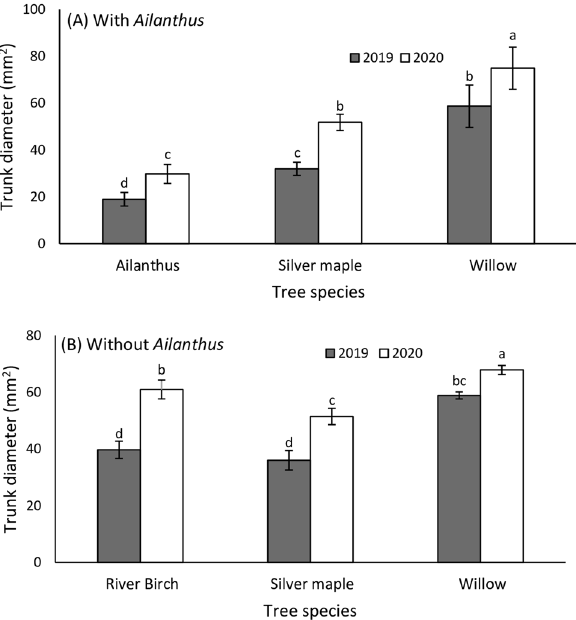
Figure 1. Mean (± SE) trunk diameter (mm) of tree species in enclosures with Ailanthus ( A ) and without Ailanthus ( B ) ( n = 5 enclosures) in 2019 and 2020. Measurements were made on October 31, 2019 and November 3, 2020. Means within a column followed by different letters are significantly different (Bonferroni post hoc test: P < 0.05). Black walnut trees were not included in the analysis because most died during the 2019 studies and had to be replaced in spring of